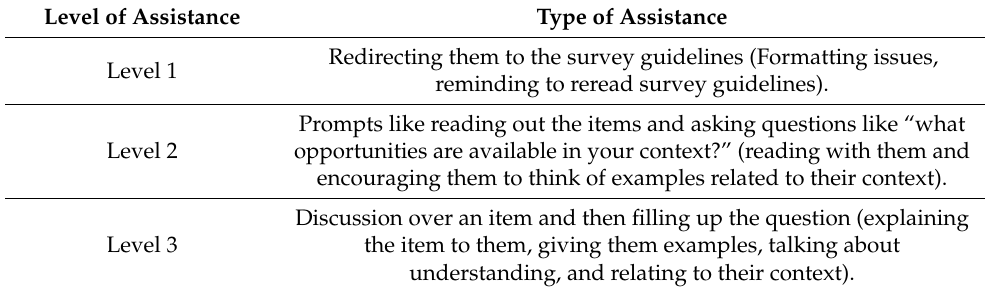
Table A1. Likert Scale for Level of